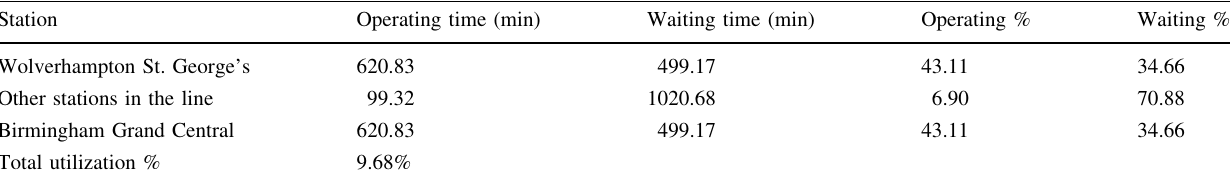
Table 12 Total utilization of the metro line in clockwise direction Station